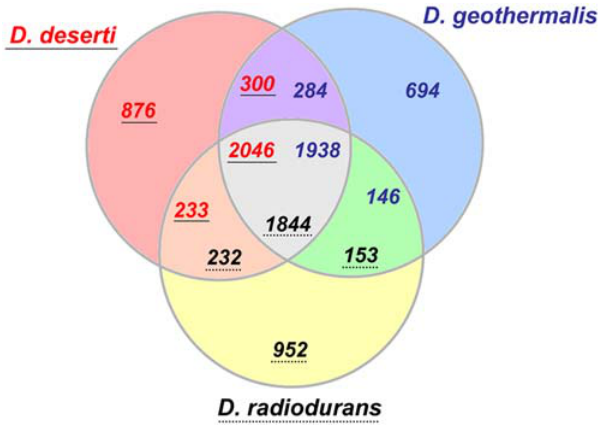
Figure 3. Orthologous gene comparison between the three sequenced Deinococcus strains. Orthologous genes are defined by BLAST search when their gene products shared a minimum of 30% identity and 70% coverage. The circle intersections give the number of genes found in two or three of the compared species, including paralogous CDSs. Numbers of genes specific to each species are represented outside these areas. D. deserti gene numbers are in red and underlined, those of D. radiodurans are in black with dotted underlining, and those of D. geothermalis are in blue and not underlined.